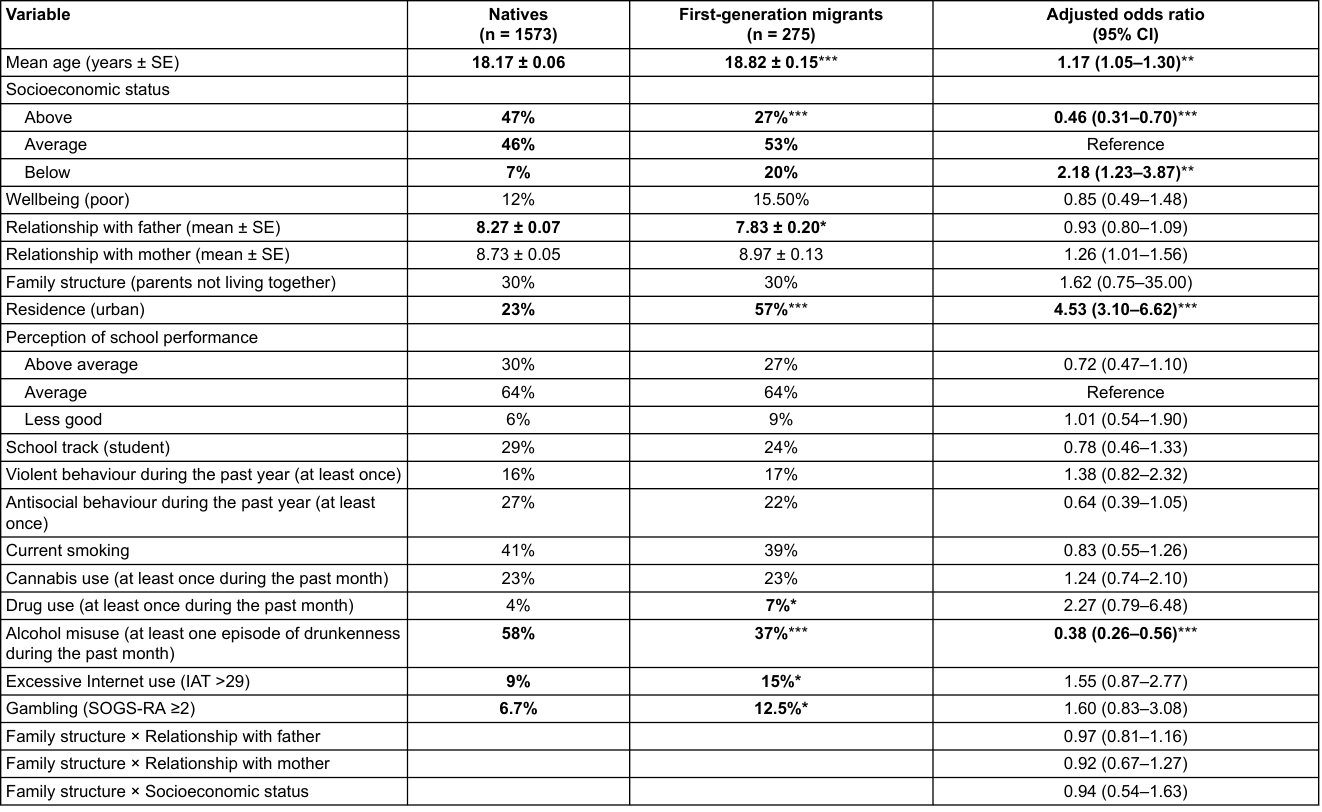
Table 1: Boys: comparison of first-generation migrants vs natives in the age group 15–24 years in post-mandatory schools.